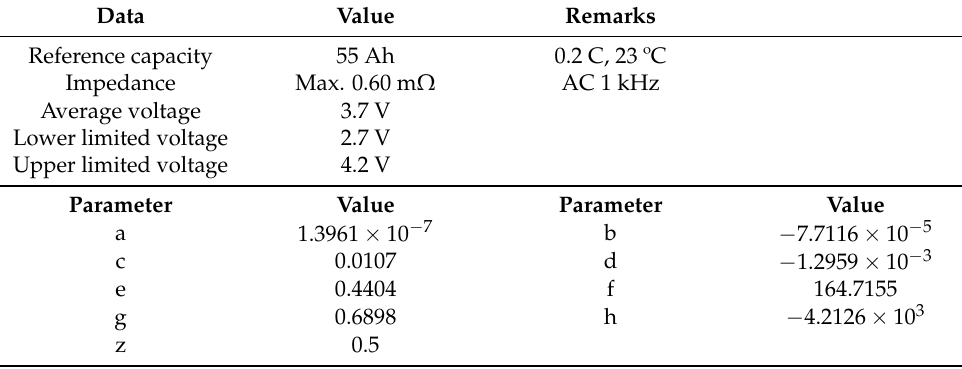
Table 2. Battery model data and parameters